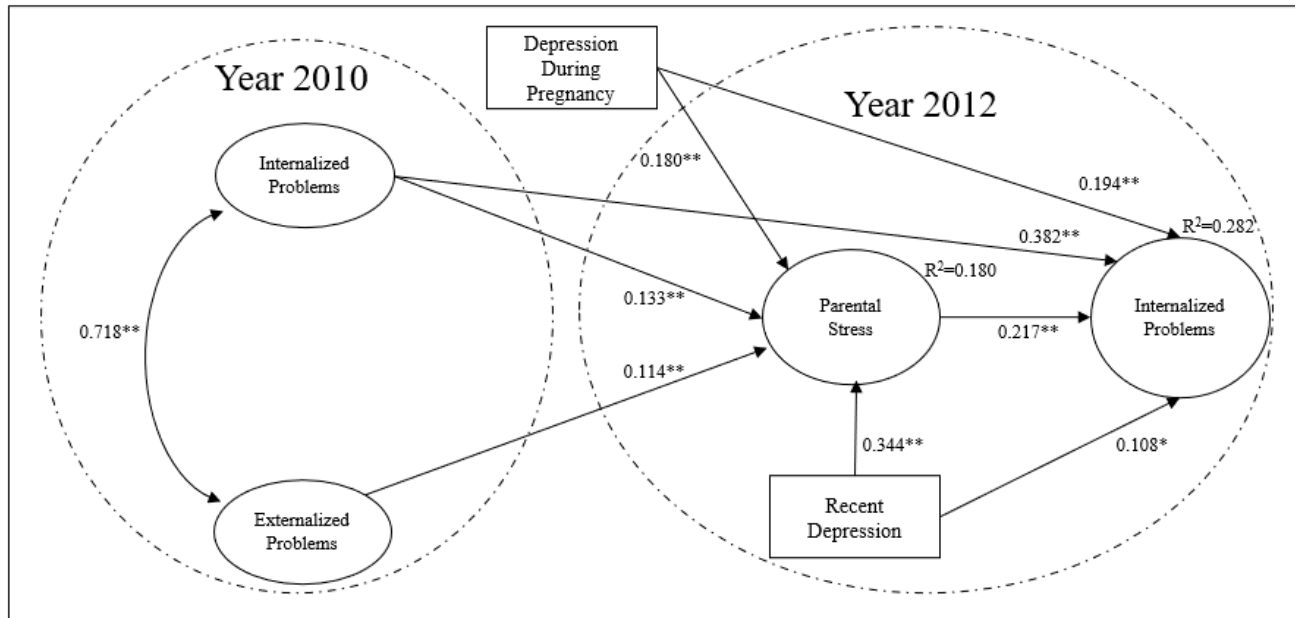
Figure 2. Explanatory model of internalized problems “**” p < 0.001, “*” p < 0.05. The standardized β s are presented for the latent variables, and the non-standardized β s for the observed variables. Only the statistically significant associations of the most relevant variables from the theoretical point of view are presented in this study.